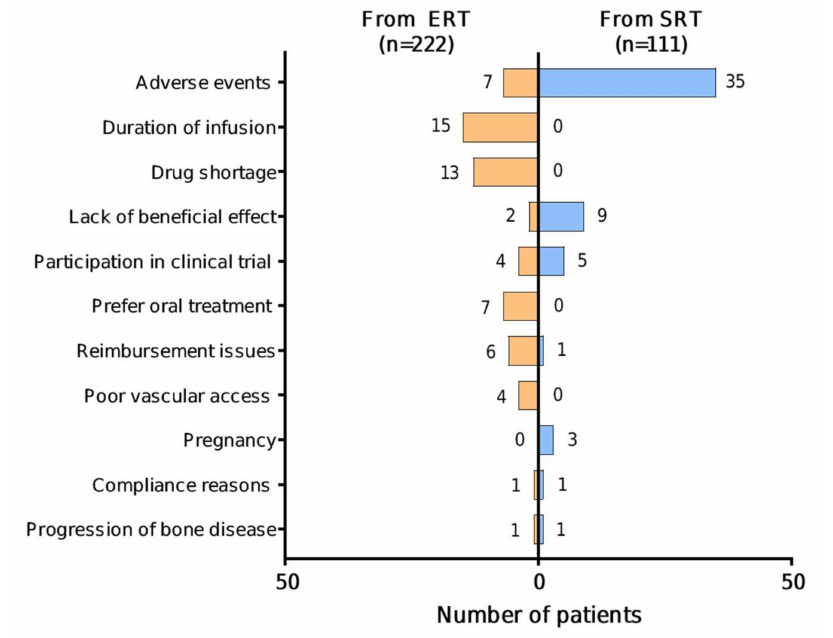
Figure 3. Reasons for